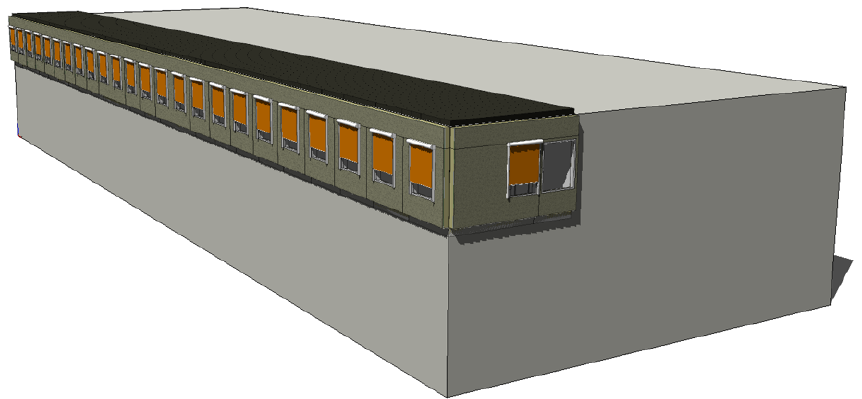
Figure 4. Office building modelled in